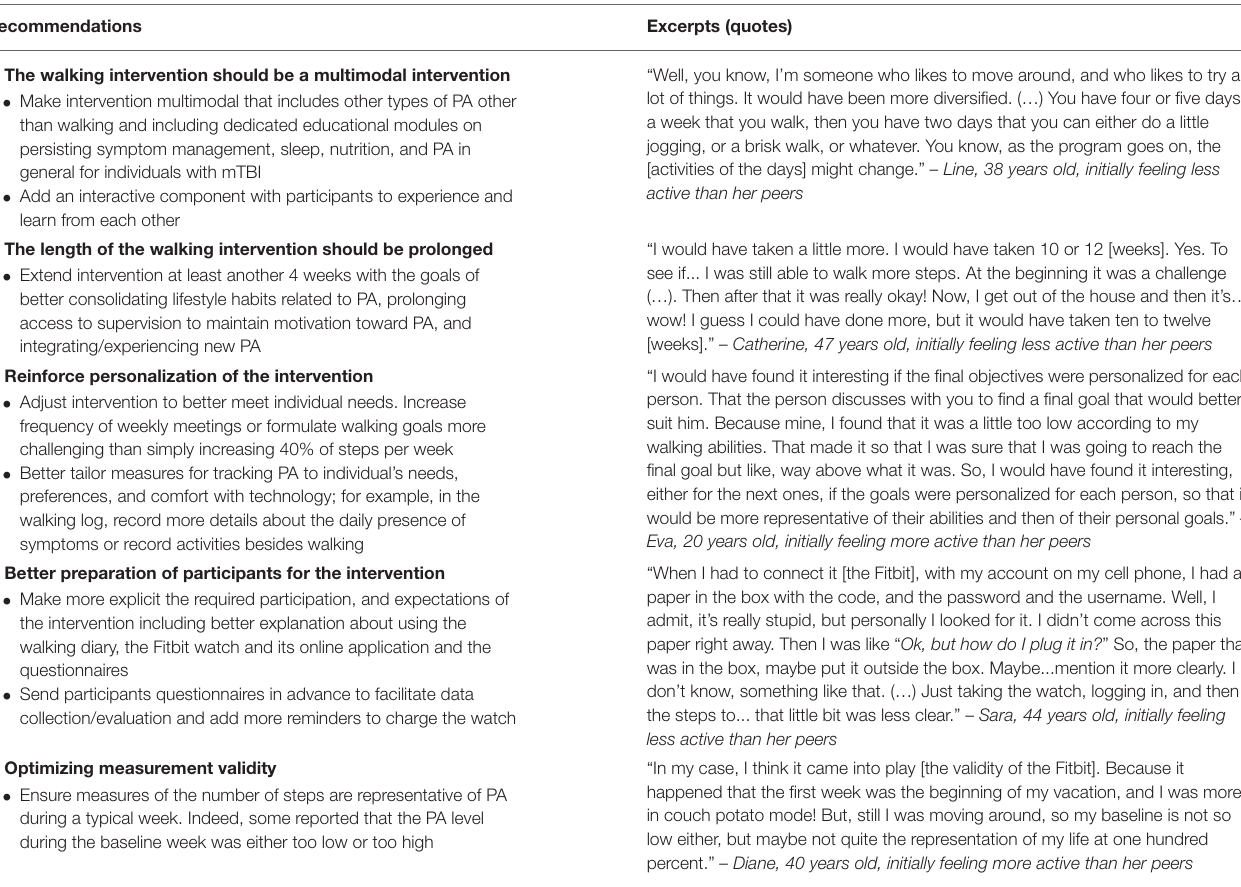
TABLE 3 | Participants’ recommendations and excerpts to improve the remotely delivered interventions ( n =